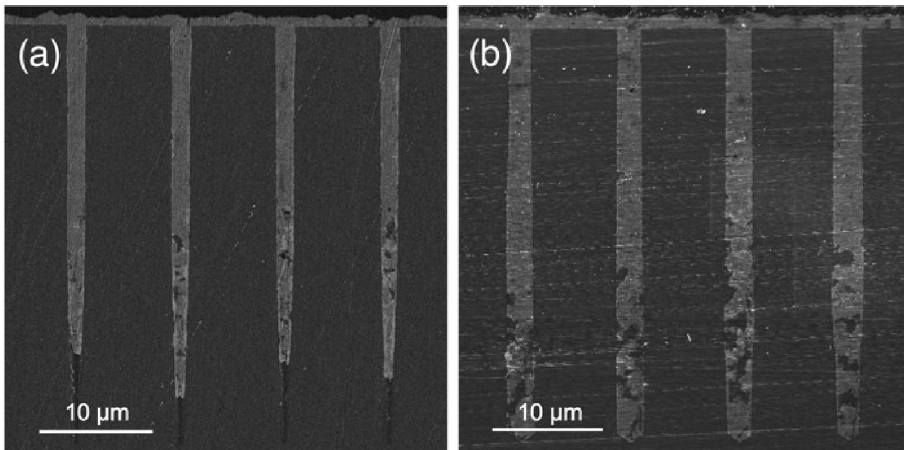
Figure 4. Scanning electron micrograph of finished TSVs fabricated without ( a ) and with ( b ) the Michelangelo step. The two wafers were cut and side-polished to obtain sub-50 nm roughness. Then, for clearer SEM imaging, the sides of the dices were coated with a 13 nm thin carbon film. The apparent difference in aspect ratio between the two images is due to the position of the cut, which was very challenging to align in the very center of the hole in both